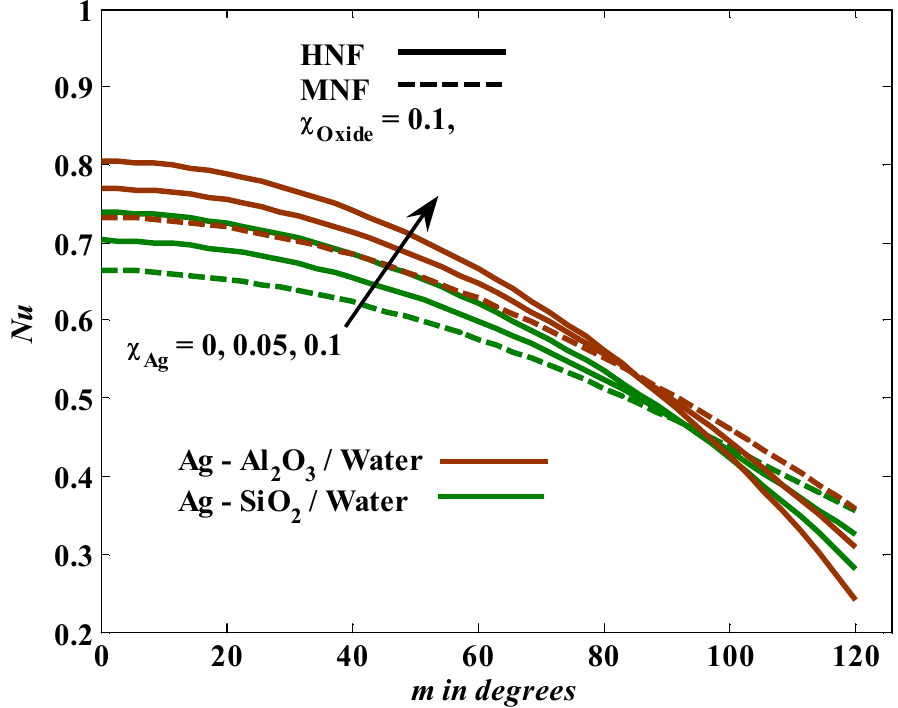
Figure 10. Illustration of χ Ag versus Nusselt number at fixed values of We = 0.2,